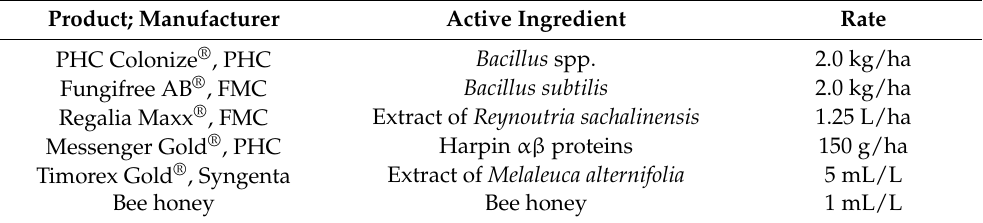
Table 3. Biorational products tested for control of tomato diseases in the greenhouse trials.